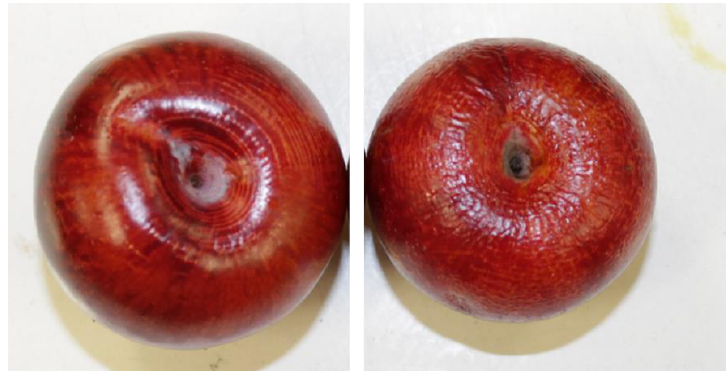
Figure 1. Shriveled versus non-shriveled ‘African Delight™’ plum.